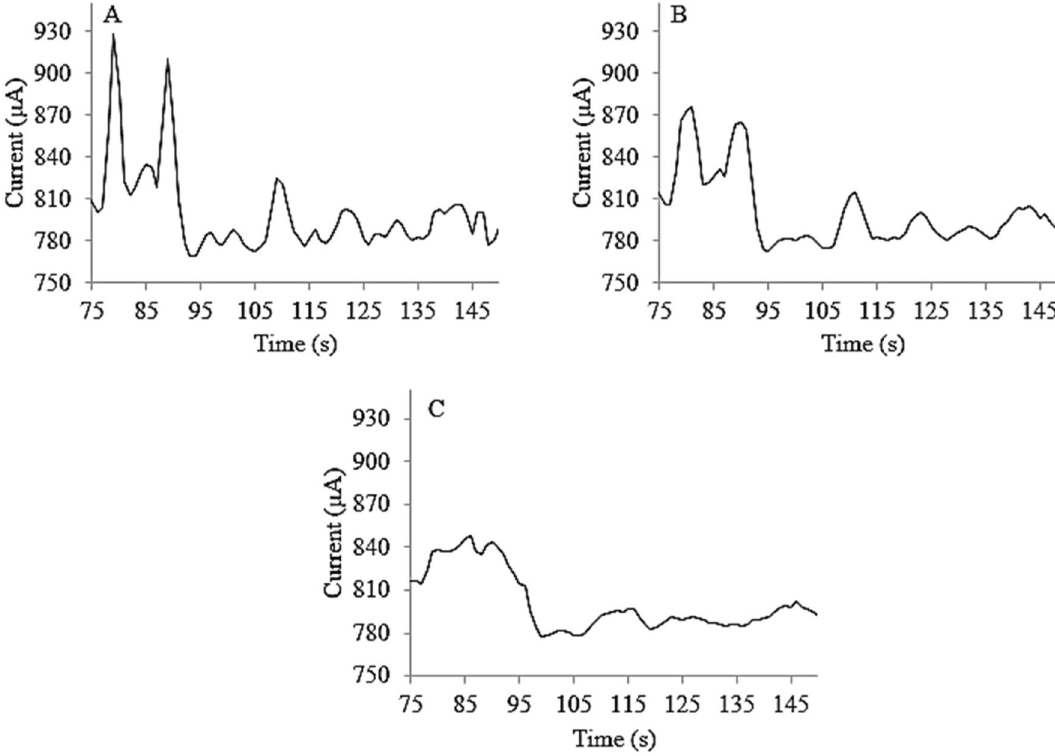
Figure 4. Time domains (free induced decay, current–time diagrams) of ( A ) C. tenuiculis , ( B ) ydatid cyst and ( C ) Coenurus cerebralis after applying the Sin(t) waveform. Triggered electrical potential: + 1.50 ± 0.01 V (vs. the pseudo reference probe). Time interval: 5.0 min. Inter-electrode distance: 0.50 cm, frequency step: 2